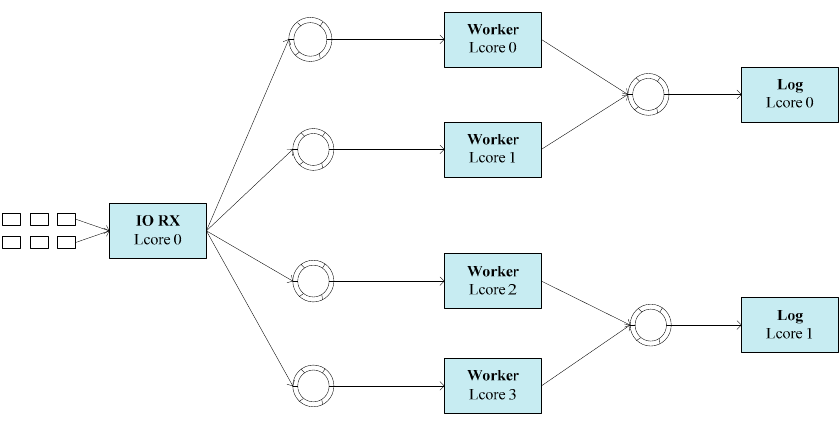
Figure 1. The framework of packet processing system.